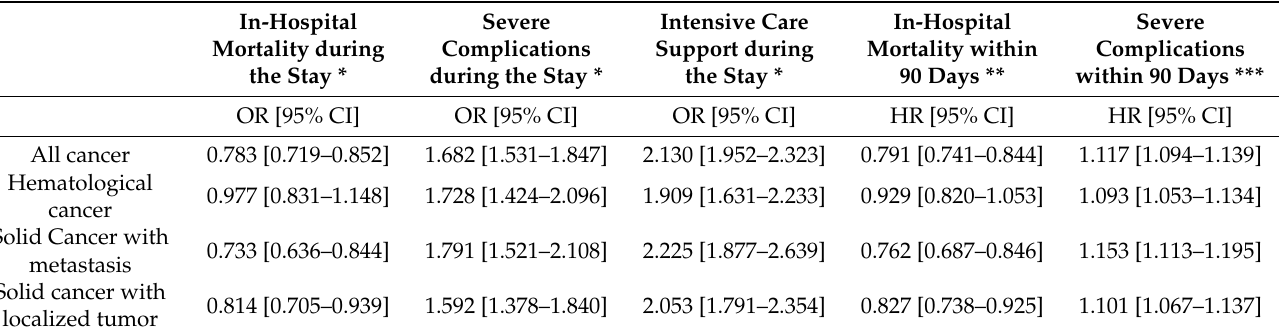
Table 4. Effect of obesity by type of cancer on the different outcomes, among COVID-19 cancer patients.